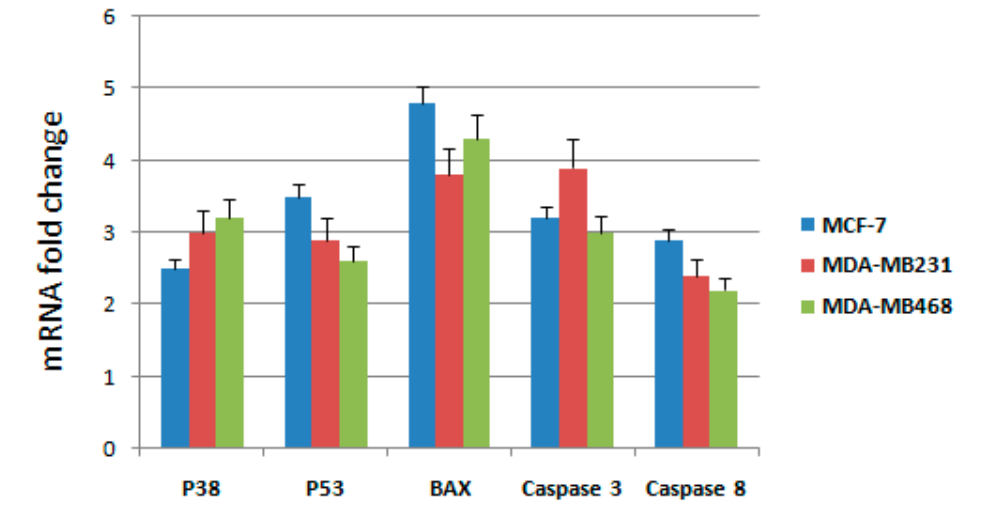
Figure 3. RT-qPCR analysis: mRNA fold changes were evaluated as ratios between the expression levels of five genes in three breast cancer cell lines, MCF-7, MDA-MB231 and MDA-MB468, after treatment with the active fraction compared to untreated cells.